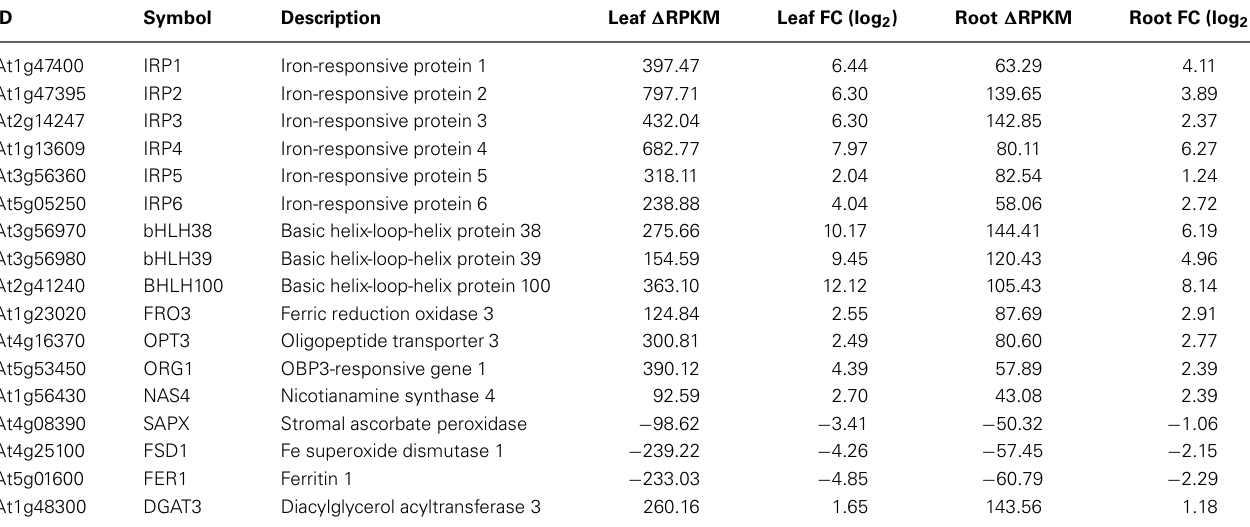
Table 1 | Genes that were differentially expressed between Fe-sufficient and Fe-deficient plants in both leaves and roots with a (cid:2) RPKM > 40 and FC > 2 at P < 0 .